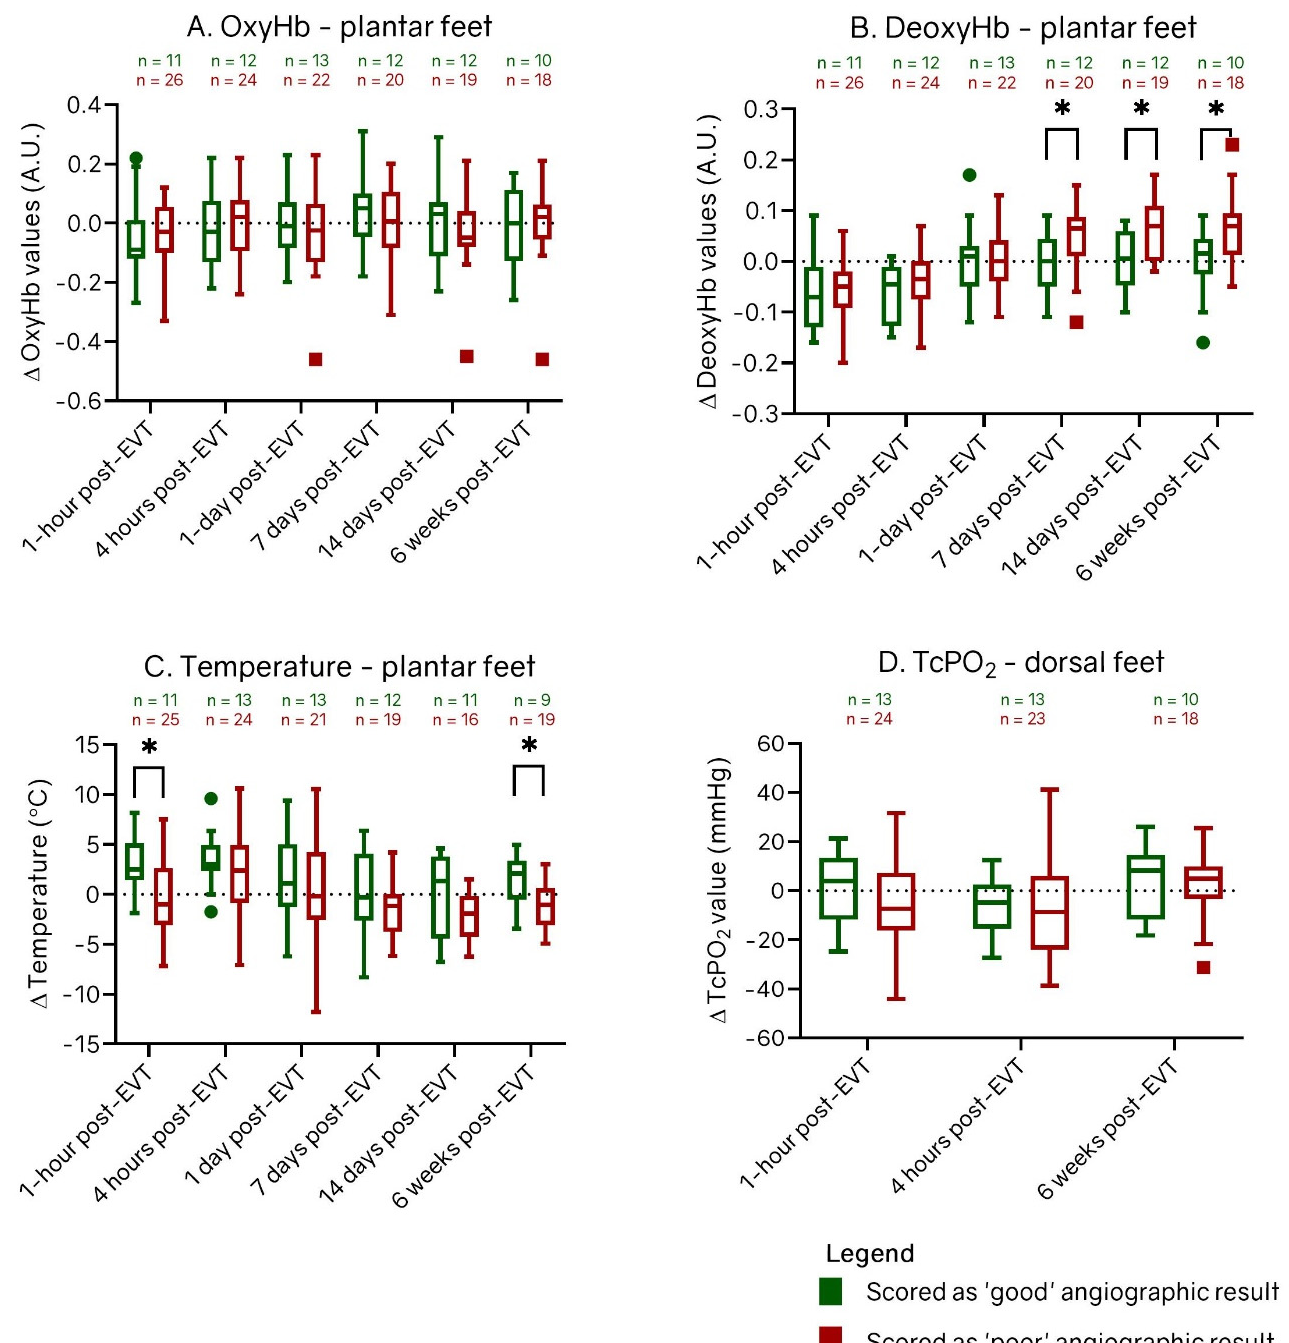
Figure 5. Box-and-whisker plots of change between patients with and without a good angiographic result in ( A ) oxyhemoglobin (OxyHb), ( B ) deoxyhemoglobin (DeoxyHb), ( C ) temperature values at the plantar side and ( D ) change in transcutaneous oxygen pressure (TcP O 2 ) values at the dorsal side of all treated feet after endovascular therapy (EVT). Groups are divided in limbs scored as good angiographic result (green) and as poor angiographic result (red). The horizontal line in the middle of each box indicates the median; the top and bottom borders of the box mark the 75th and 25th percentiles, respectively, and the whiskers mark the highest value and lowest value within 1.5 × IQR of the 75th and 25th percentiles. The dots are outliers of patients with clinical improvement and the squares are outliers of patients without clinical improvement. A.U.: arbitrary Units. * p < 0.05.